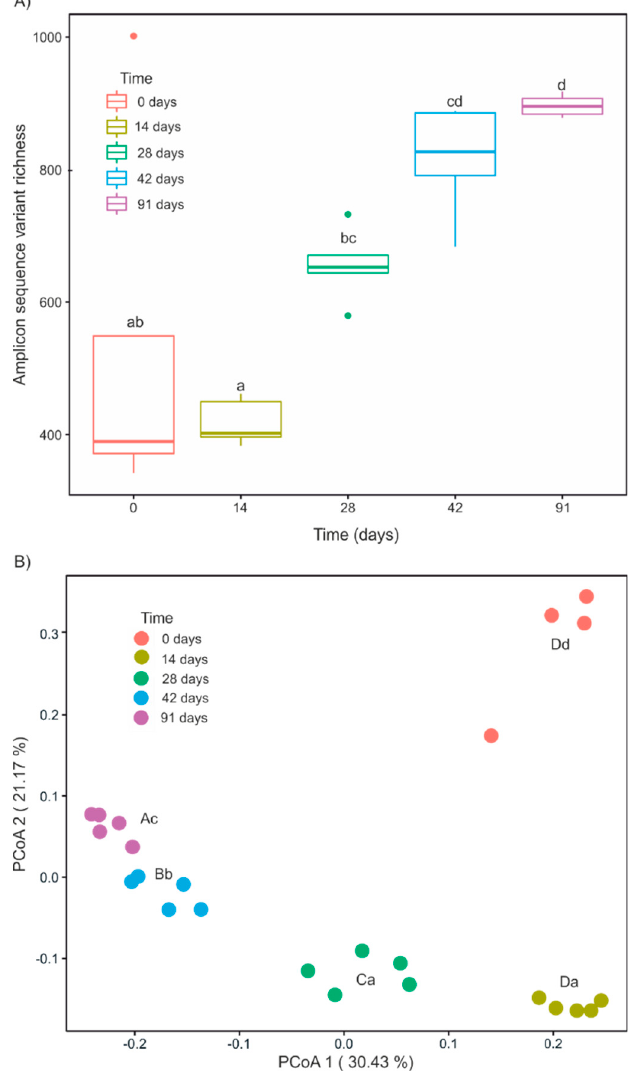
Figure 3. Changes in bacterial α -diversity and β -diversity during vermicomposting of grape marc derived from the red winemaking process of the grape variety Mencía. ( A ) α -diversity is described in terms of amplicon sequence variant (ASV) richness. Letters indicate significant differences between time points (Tukey HSD test). ( B ) β -diversity is shown with principle coordinate analysis of weighted UniFrac distances. Capital and lowercase letters indicate significant differences between the time points in PCoA1 and PCoA2 scores respectively (Tukey HSD test, FDR corrected).